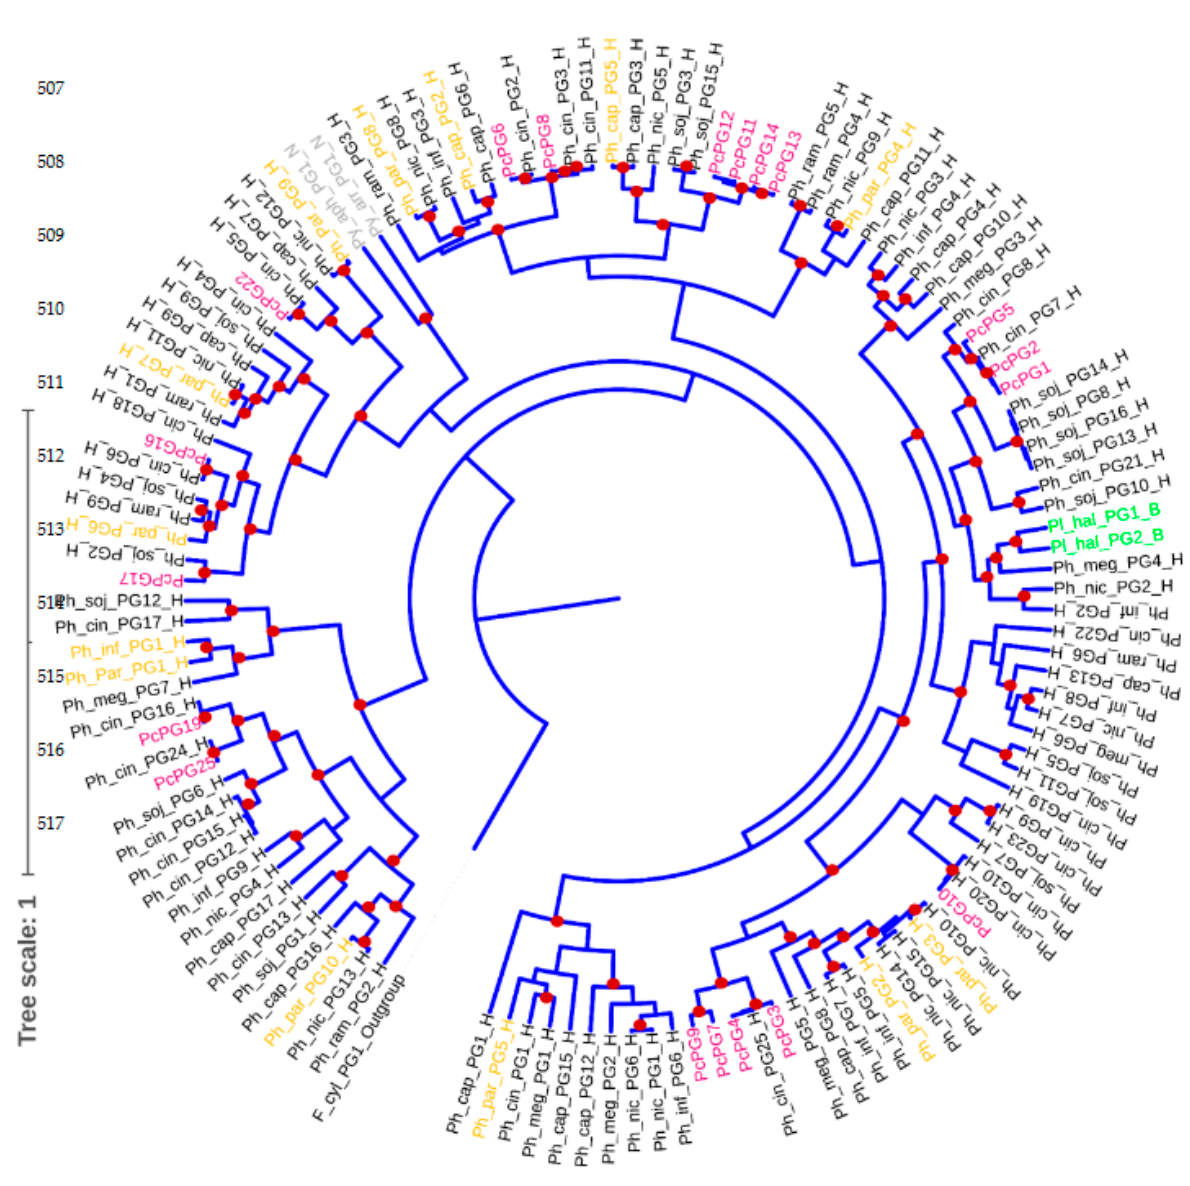
Figure 2. Phylogenetic analysis of PGs from oomycete species. The phylogenetic tree was constructed using BEAST over a chain length of 50 million and sampling per 1000 states. Significant posterior probabilities (>0.95) are indicated by red dots on the nodes. Oomycetes PGs with different trophic lifestyles, B—biotrophic, H—hemibiotrophic, N—necrotrophic, were used for the phylogenetic tree construction, with Fragilariopsis cylindrus as an outgroup. PG sequences from Phytophthora cinnamomi identified in this study are highlighted in purple. Characterized PG sequences from Phytophthora spp. are highlighted in orange. The PGs from biotrophic and necrotrophic species are highlighted in green and grey, respectively.